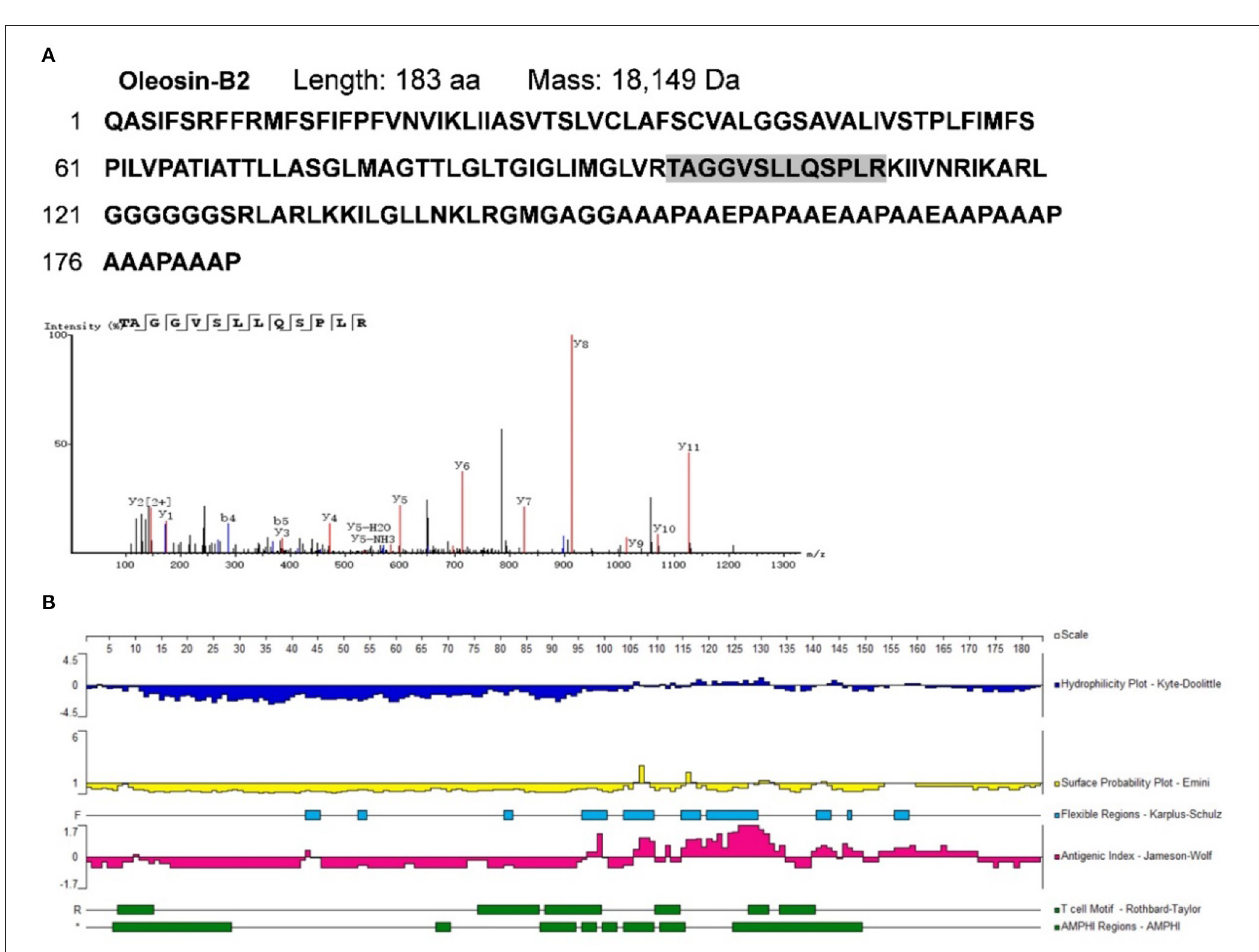
FIGURE 2 | (A) The amino acid sequence of oleosin-B2 containing the shade part which indicated the identified amino acid sequence fragment by proteomics analysis. The mass spectrum of the identified amino acid sequence fragment was displayed. (B) Epitope prediction of oleosin-B2 for acting with T cells and B